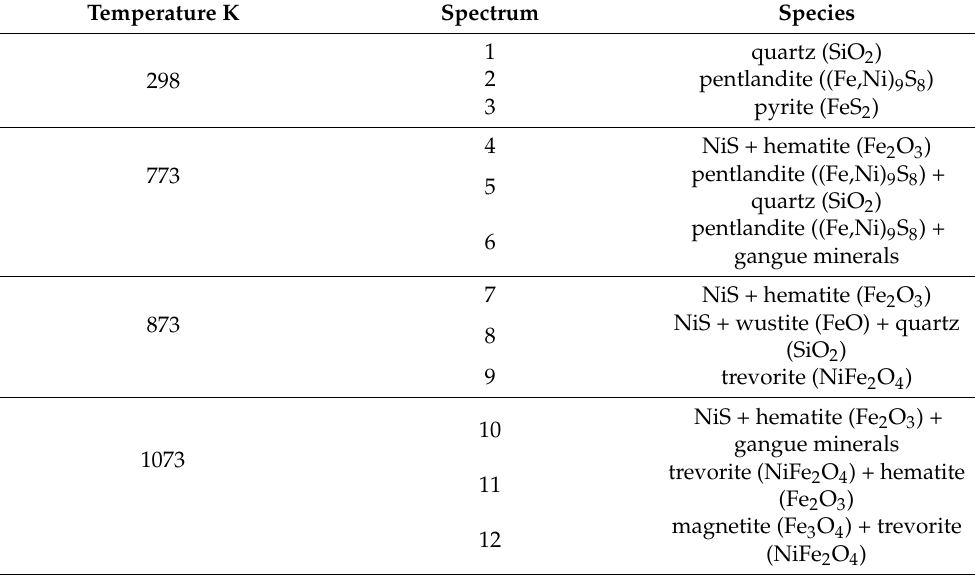
Figure 2. Microphotographs with EDS analysis of the pentlandite-bearing ore ( a ) 298 K and the initial sample roasted at ( b ) 773 K, ( c ) 873 K and ( d ) 1073 K. Table 2. Phase composition of the initial sample and the oxidation products according to EDS analysis.